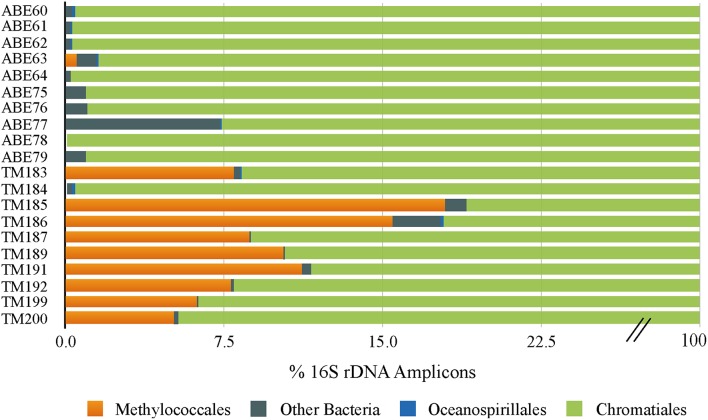
Bar graph showing the distribution of 16S rRNA OTUs in Ifremeria nautilei from ABE and Tui Malila vent fields.